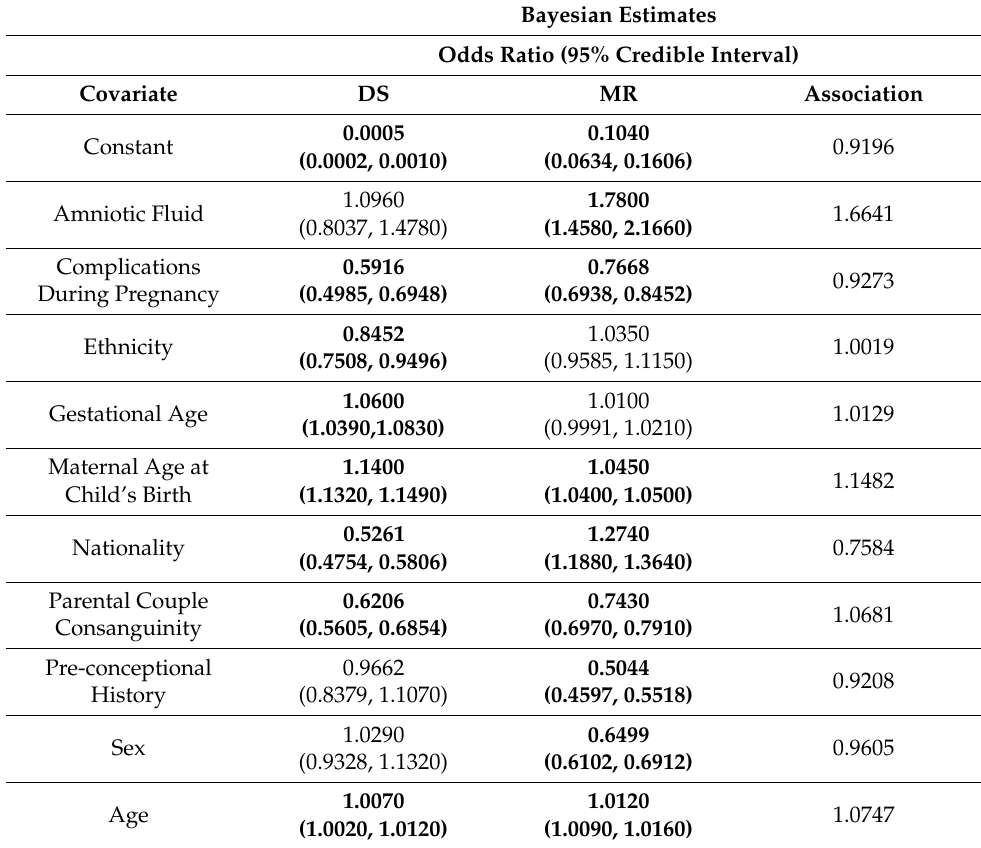
Table 2. Bayesian odds ratio estimates (95% credible interval in parentheses) for the bivariate logistic regression model for both DS and MR diseases along with their